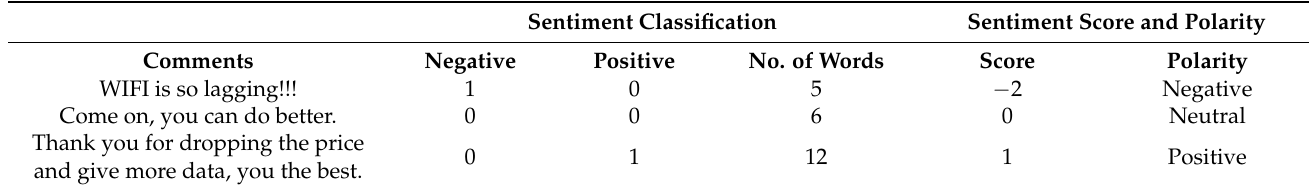
Table 7. Random preview of polarity results.